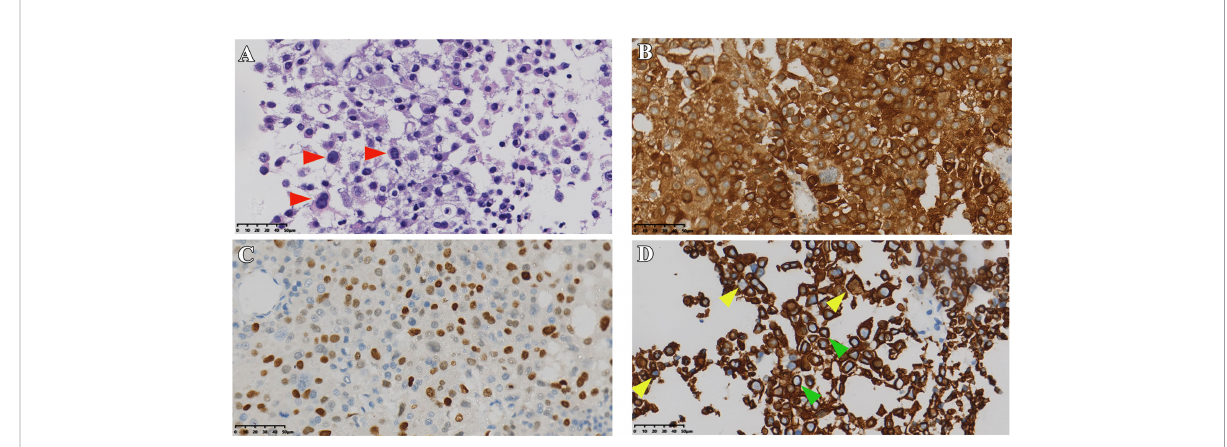
FIGURE 3 Pathological sections of case 2. (A) HE staining of tumor (red arrows indicate typical Crooke ’ s hyaline change). (B, C) Immunostaining of ACTH , T- PIT , and CK8/18 (D) green and yellow arrows show a round and semi-circular immunostaining of keratin, respectively). Original magni fi cation,